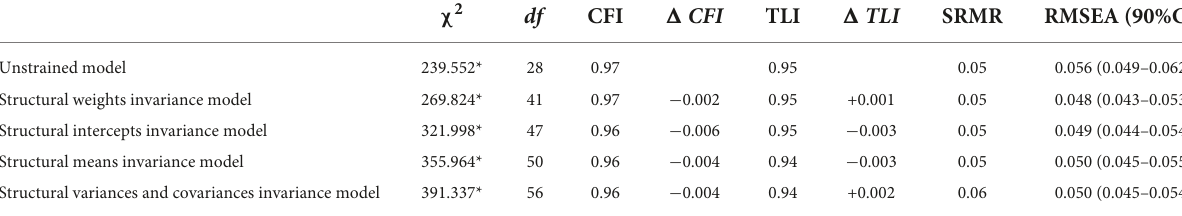
TABLE 5 Testing for structural invariance across